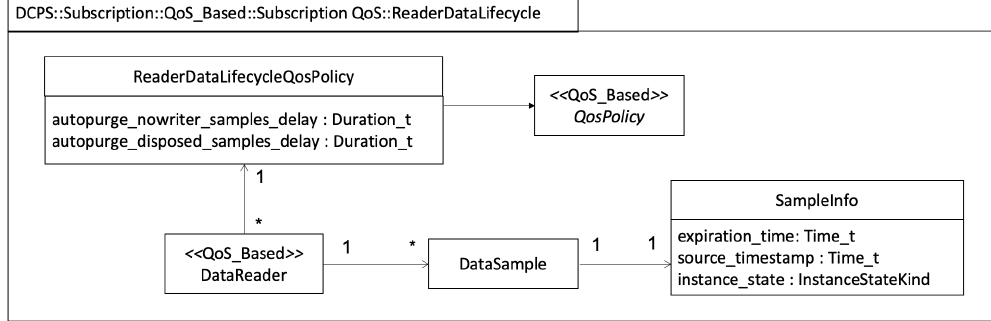
Figure 15. ReaderDataLifecycle